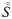
Bayesian repertoire overlap consistently estimates true overlap.Repertoires with true overlaps ranging from 0 to 60 were subsampled in simulations. As sampling rates increase from na = nb = 30 (left) to 40 (middle) and to 50 (right), the estimates of BRO (colored circles) approach the true values (dotted lines) symmetrically. Estimates from S˚ (crosses) approach the true values from below, systematically underestimating the true overlap. This bias is worse with lower sampling rates [7]. Similar results are found when na ≠ nb, and when the total repertoire sizes are different from each other (S1 Fig).